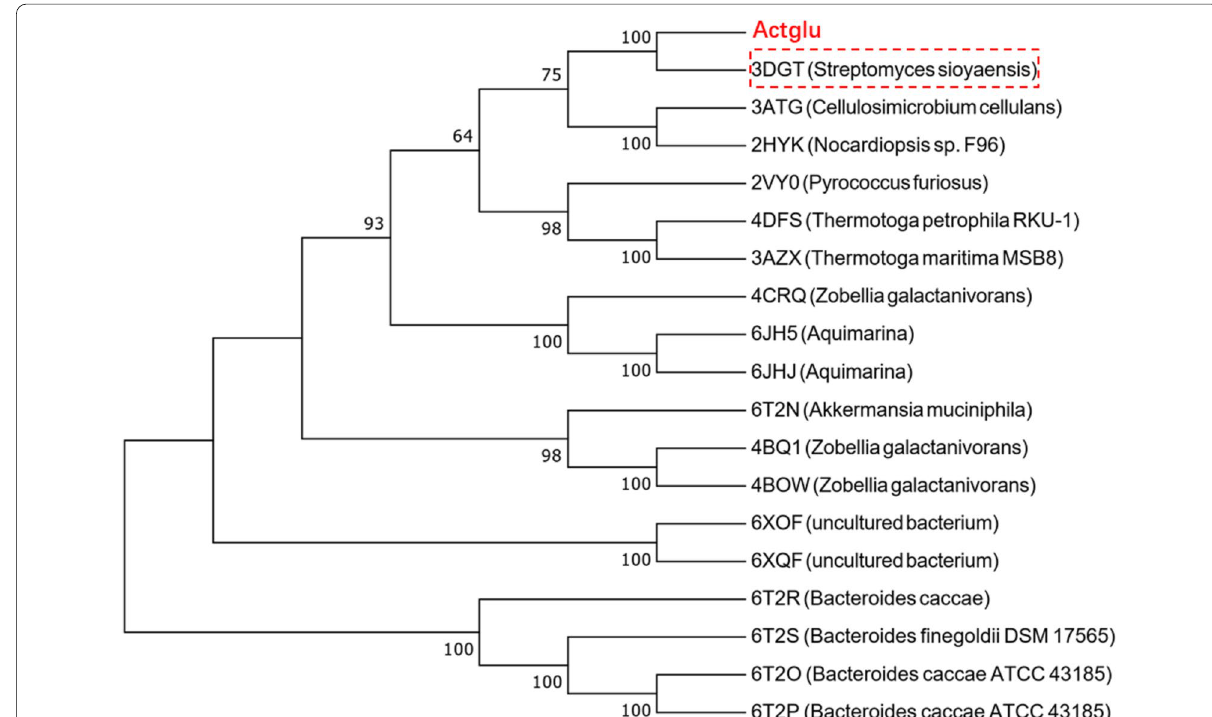
Fig. 1 The phylogenetic tree of Actglu . The β-1,3-glucanase is most homologous with a GH16 family glucanase (PDB 3DGT) from Streptomyces sioyaensis , which belongs to Streptomyces, Streptomycetaceae, Streptomycineae,